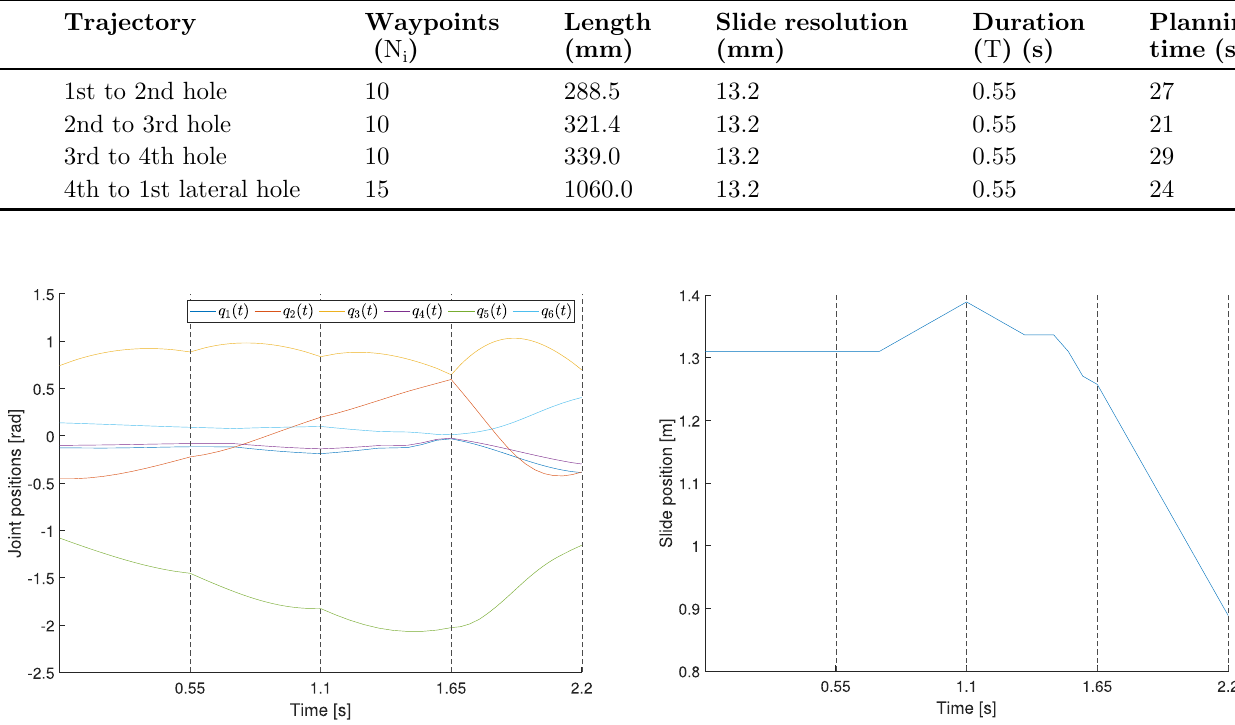
Fig. 5. Planned joint and slide positions for trajectories 1 – 4 plotted in sequence. The end of each trajectory is indicated with a dotted